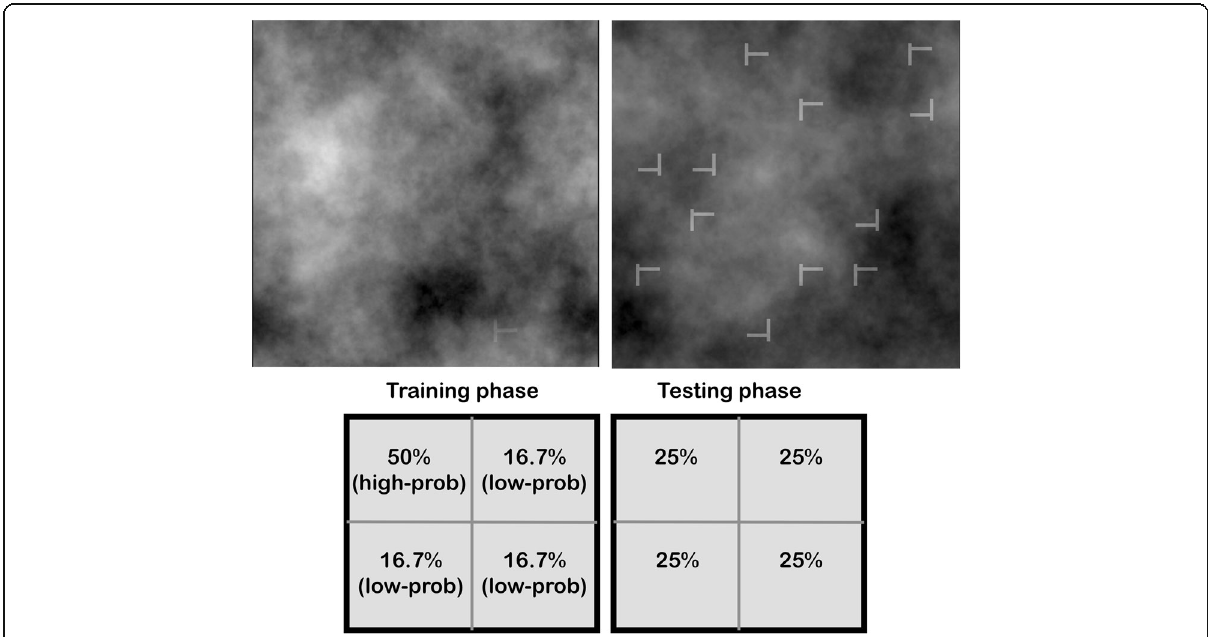
Fig. 1 Top : Sample visual search trials. Top left : The detection task. For illustrative purposes, the noise opacity used in this example (92%) differs from that used in the actual experiment (mean 93%). Top right : The discrimination task. Bottom : The target ’ s location probability in the two phases of the